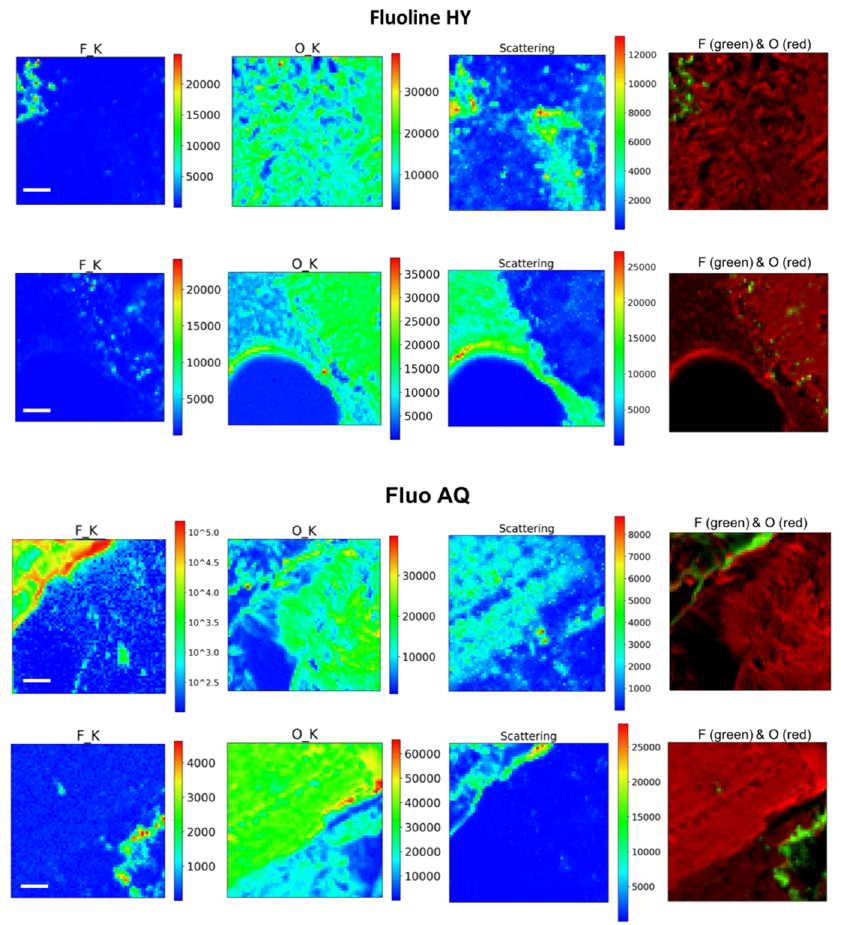
Figure 3. Elemental XRF maps (acquired at 1 keV with 1.2 µ m diameter beam size, over an area of 80 × 80 µ m 2 ) obtained for Cusa’s stone treated with Fluoline HY ( top ) and Fluo AQ ( down ). The scale bar is 20 µ